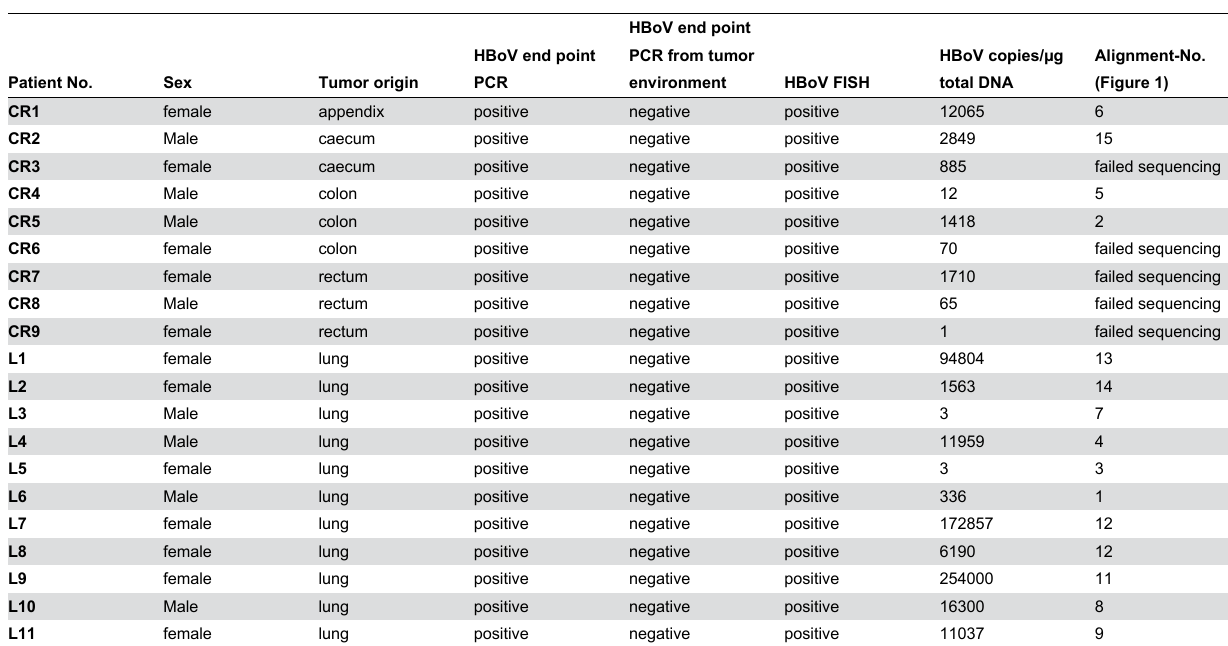
All probes were coupled to fluorochromes at their 3’- and 5’-ends to enhance the fluorescence signals. Table 2. Patients, tumor types and qPCR results from tumor tissues.